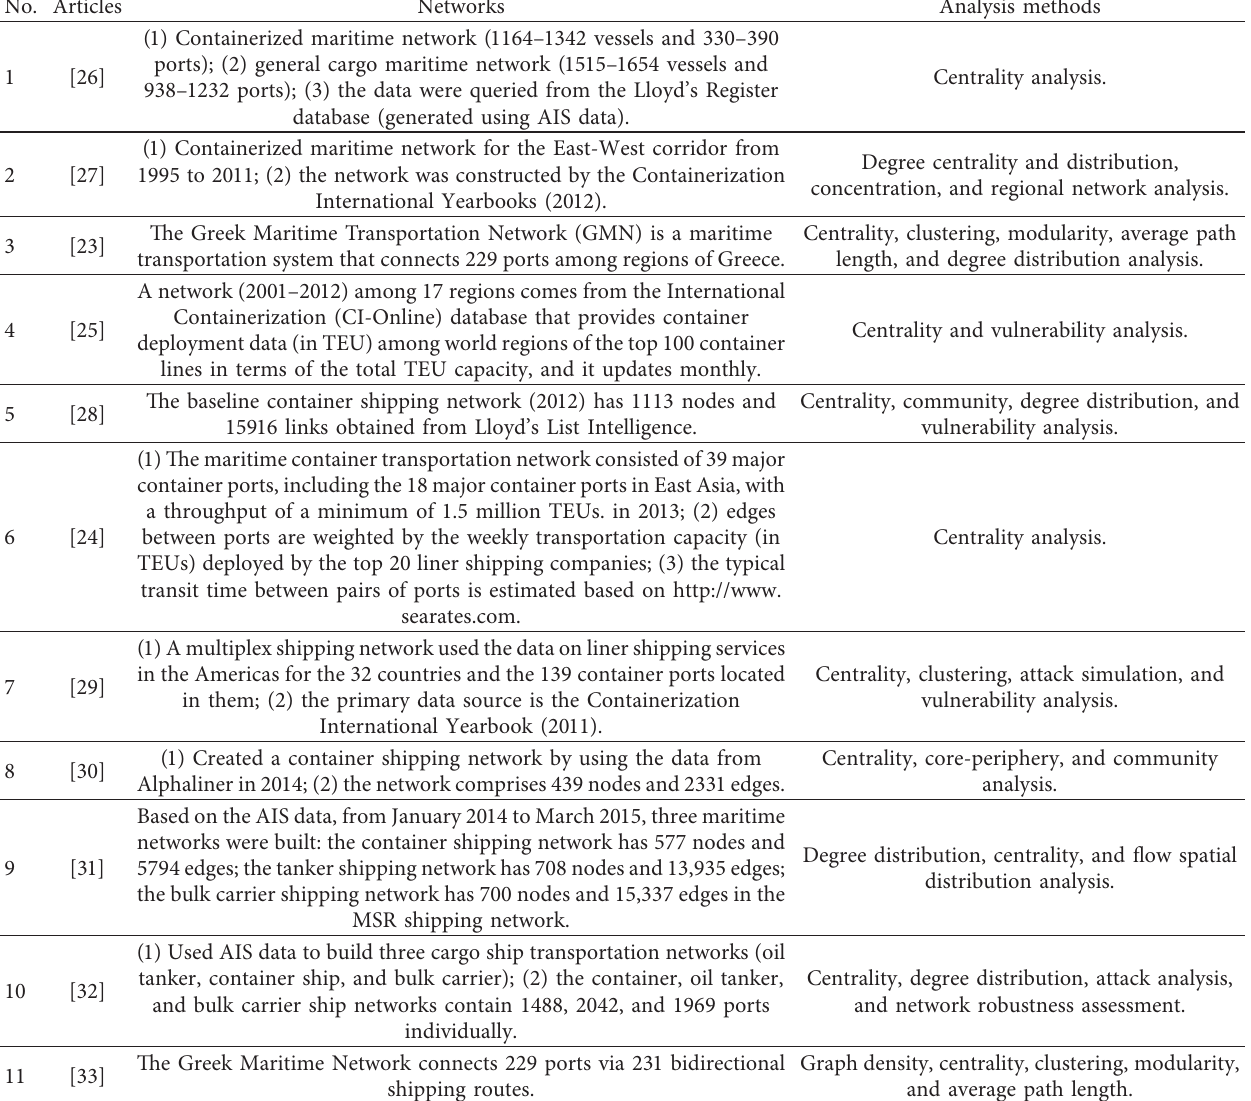
Table 1: Maritime network studies using network analysis